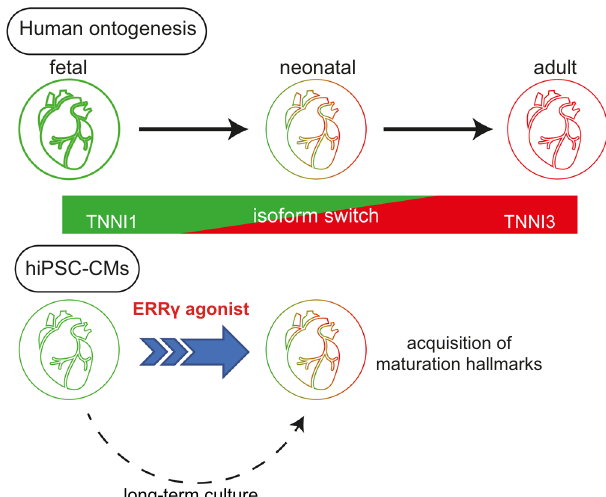
Fig. 7 hiPSC cardiac maturation model. Schematic representation of an ERR γ agonist inducing the cardiac neonatal-like